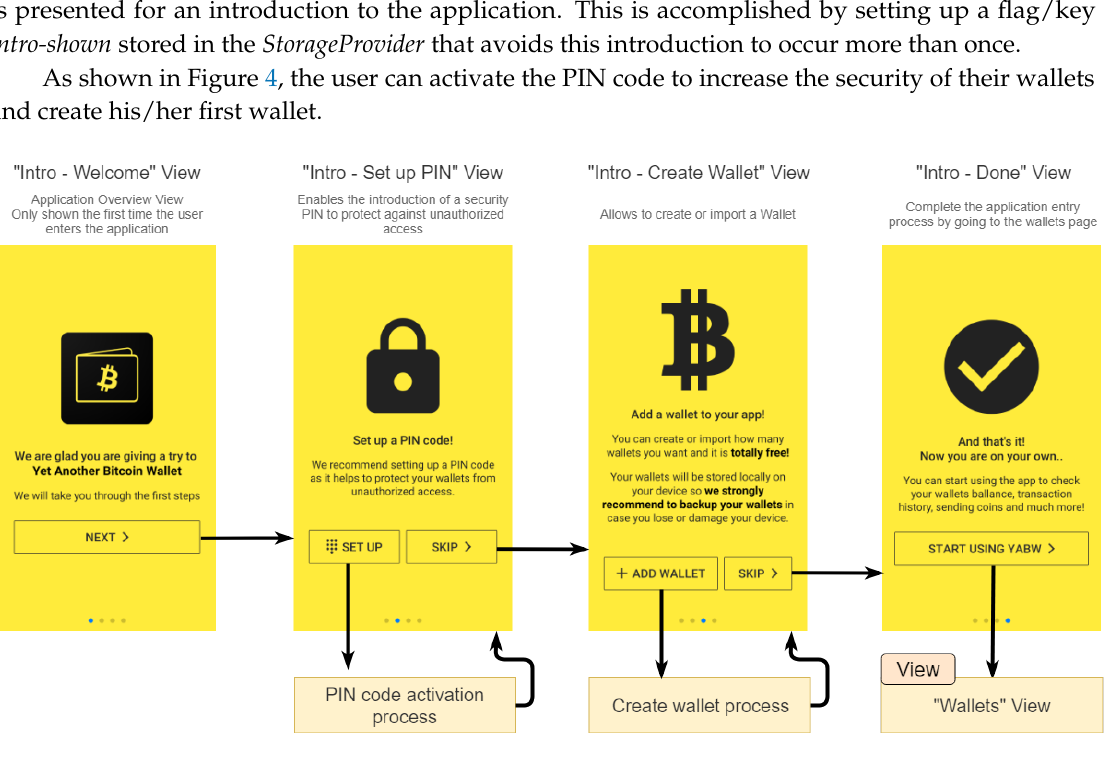
Figure 3. Yet Another Bitcoin Wallet (YABW) components—an example [C4–Level 3].